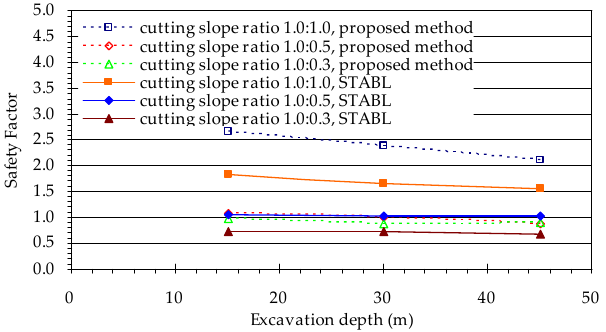
Figure 9. Safety factor obtained using the proposed method and the conventional slice method for various excavation depths.